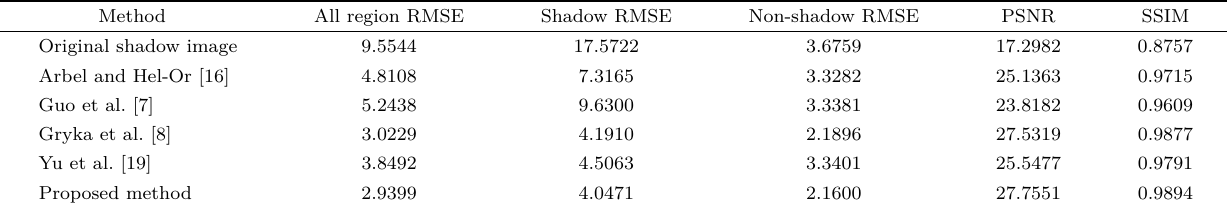
Table 3 Quantitative results on 15 images from the soft shadows dataset given by Gryka et al. [8]. The values are averages computed on the set of images